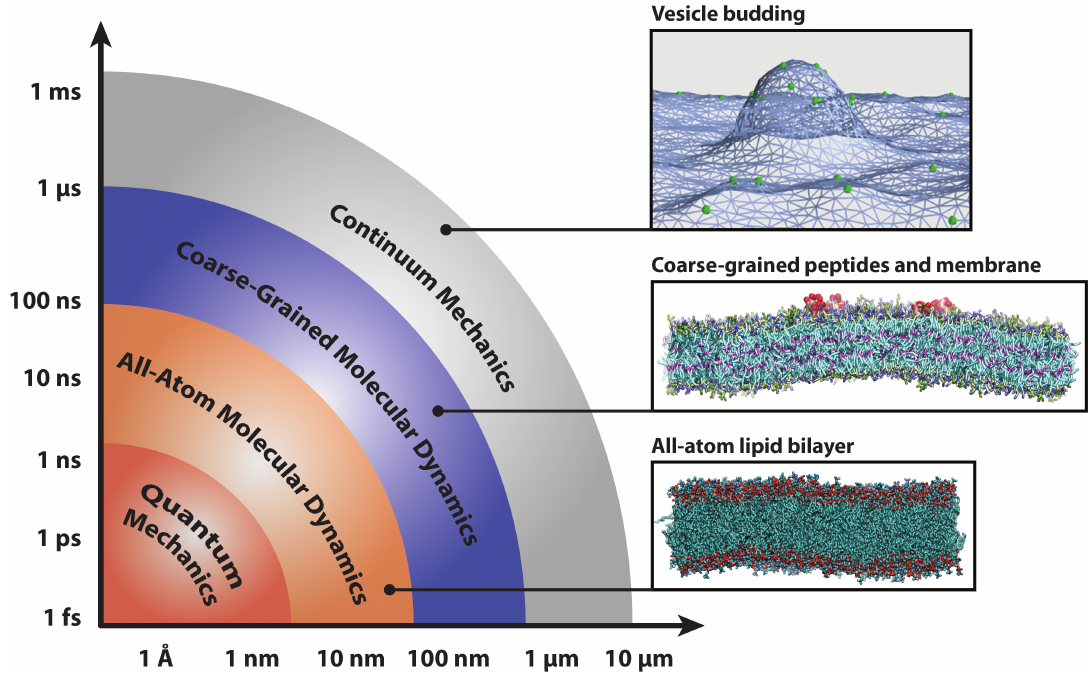
Figure 1. Diagram of computational methods for studying biophysical systems across a range of time- and length-scales. Representative snapshots depict an all-atom lipid bilayer, peptides embedded in a coarse-grained bilayer and proteins remodeling a continuum mechanics membrane model. Bilayers were simulated with the CHARMM36 [15] and Martini [16] force fields and rendered with Visual Molecular Dynamics